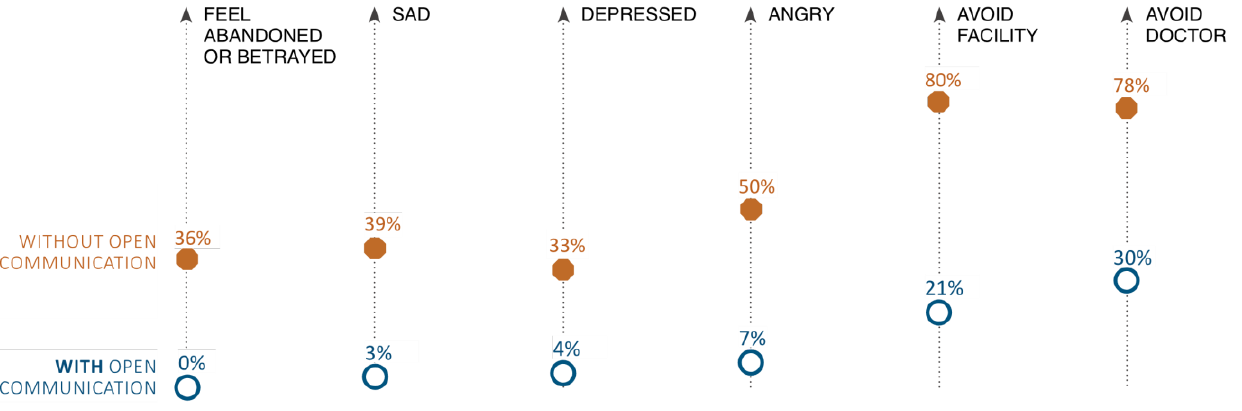
Figure 6. The connection between the open communication by providers and the lower levels of harm [57].